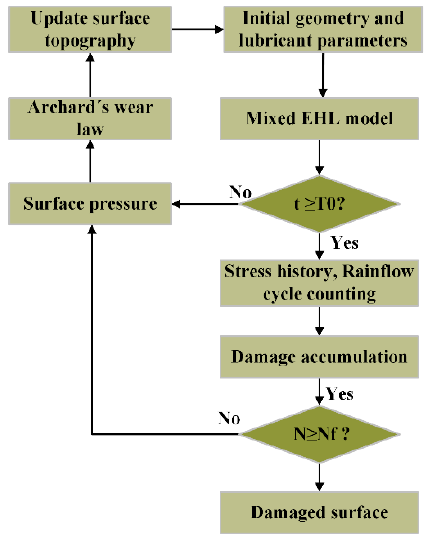
Figure 2. The technical route of the micropitting model.